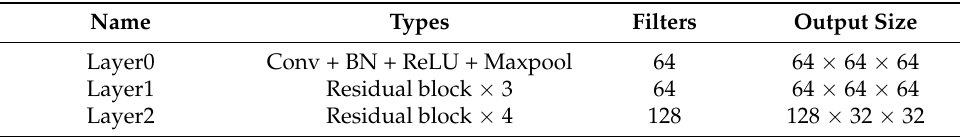
Table 2. Configuration of Siam-Conv.